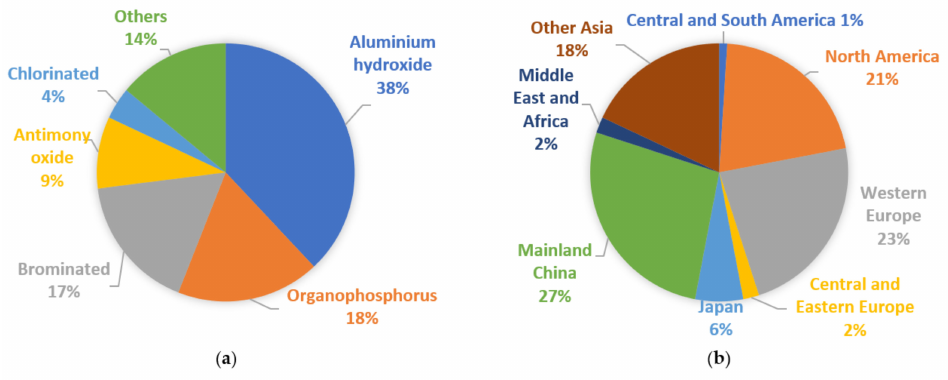
Figure 1. World consumption of flame retardants [7]: ( a ) by type; ( b ) by